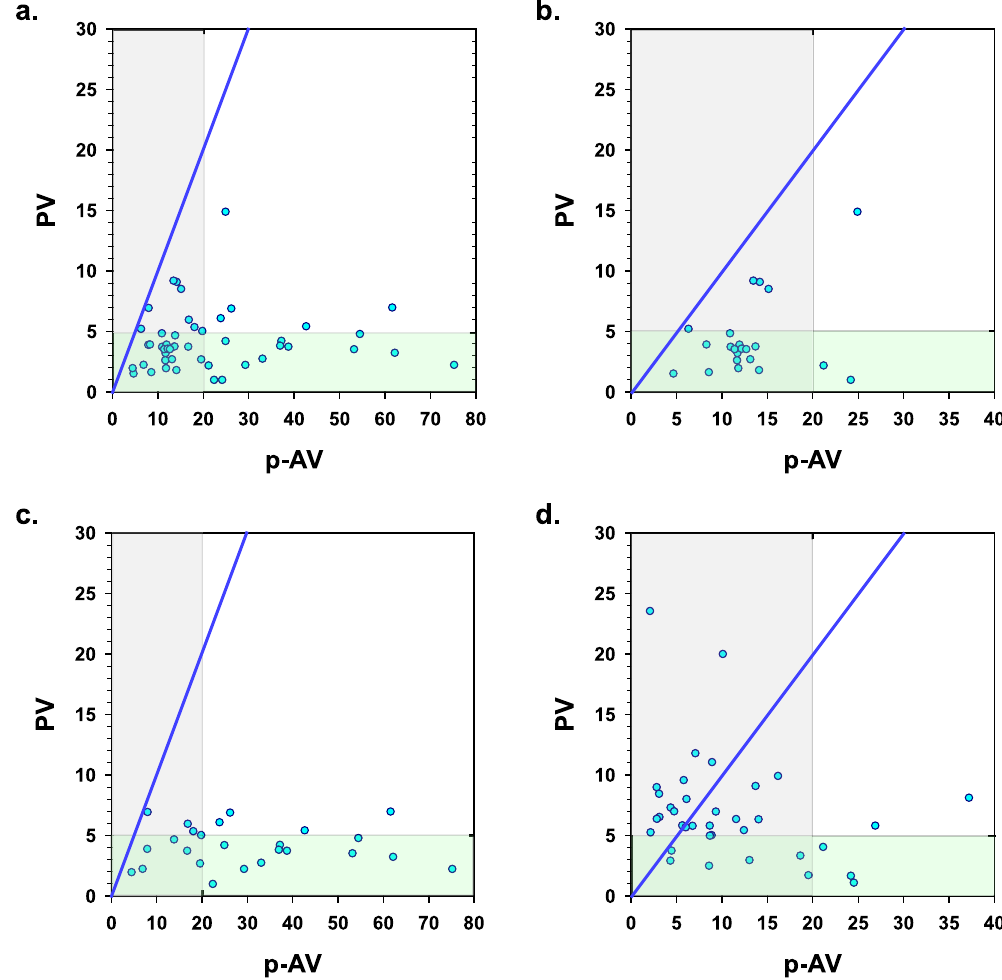
Figure 1. Comparison of the ratio of PV to p-AV of New Zealand fish oil products tested in the present study (panel a: all tested products, panel b: only unflavored oils, panel c: only flavored oils) with those reported by Albert et al . 28 (panel d). The green- and grey-shaded areas fall below the GOED maximum PV and p-AV limits of 5 meq O 2 /kg and 20, respectively. The blue line represents a PV/p-AV ratio of